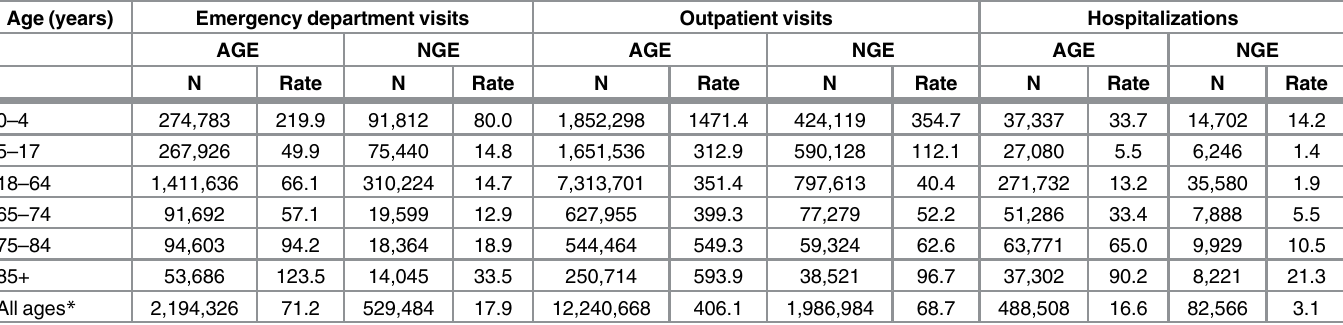
Table 2. Number and mean incidence rate (per 10,000 person-years) of all-cause (AGE) and norovirus gastroenteritis (NGE)-attributable emer- gency department visits, outpatient visits and hospitalizations (2002 – 2013, MarketScan database). Age (years)